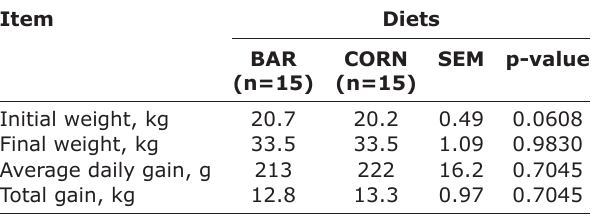
Table-4: Effects of feeding either BAR or CORN grains on growth performance of Awassi lambs.